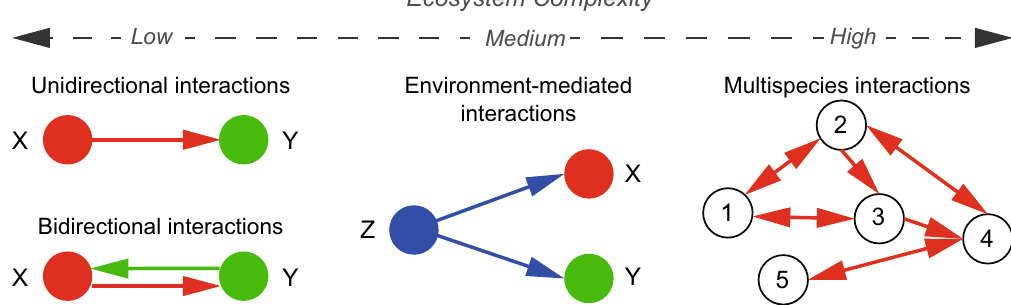
Figure 1. Studied ecosystem complexity. Epitomes of increasing ecosystem complexity are shown from left to right where nodes are representing variables (e.g. species or other socio-environmental features). Case 1 shows two basic cases: unidirectional and bidirectional interactions where true interaction strength is known because embedded into a mathematical model. Case 2 is about environment-mediated interactions with no knowledge of ”true” interactions. Case 3 is a multispecies ecosystem with multiple bidirectional interactions with no knowledge of ”true”